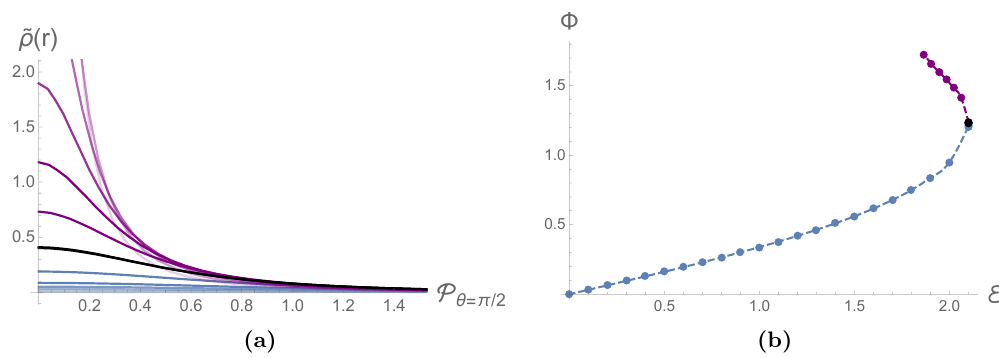
Figure 5. (a) The (cid:13)ux density through the equatorial plane as a function of the proper distance for several values of the electric (cid:12)eld. (b) Total (cid:13)ux through the equator.